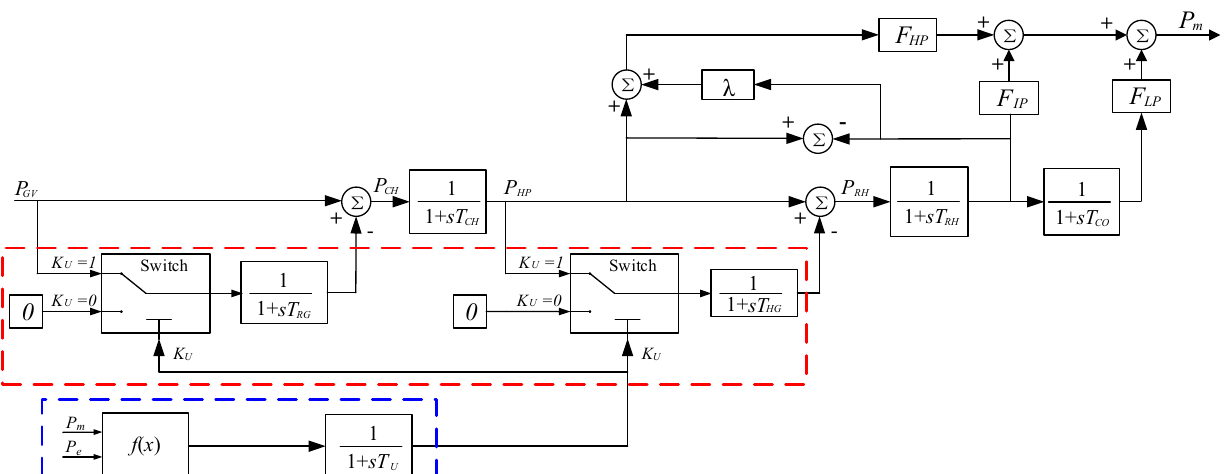
In Blue Dashed Box: Model of Regulating Valve Fast Shut Down System In Red Dashed Box: Model of B ypass And Valve Control